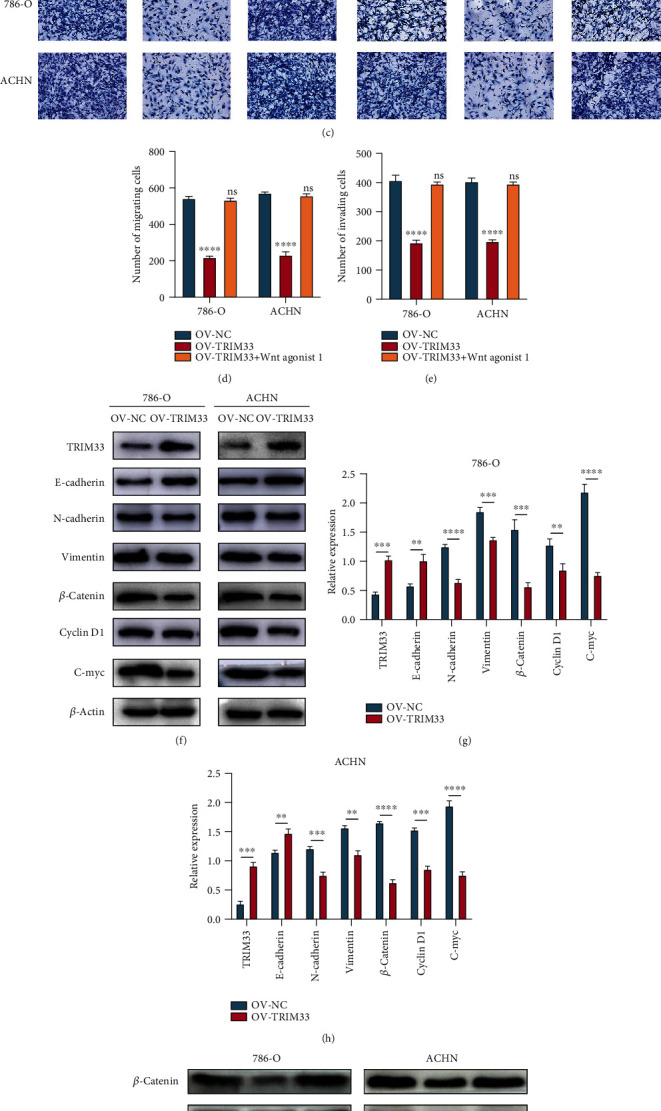
TRIM33 overexpression can inhibit migration, invasion, and EMT in ccRCC; here, the potential molecular mechanisms are explored. (a and b) Wound healing assay. (c–e) Transwell assay, including migration and invasion experiments. (f–h) Western blot assay for TRIM33, E-cadherin, N-cadherin, vimentin, β-catenin, cyclin D1, c-myc, and β-actin. (i–k) Western blot assay after incubation with a Wnt signaling pathway agonist for β-catenin, cyclin D1, c-myc, and β-actin. ∗∗P < 0.01; ∗∗∗P < 0.001; ∗∗∗∗P < 0.0001; ns represents no statistical significance.